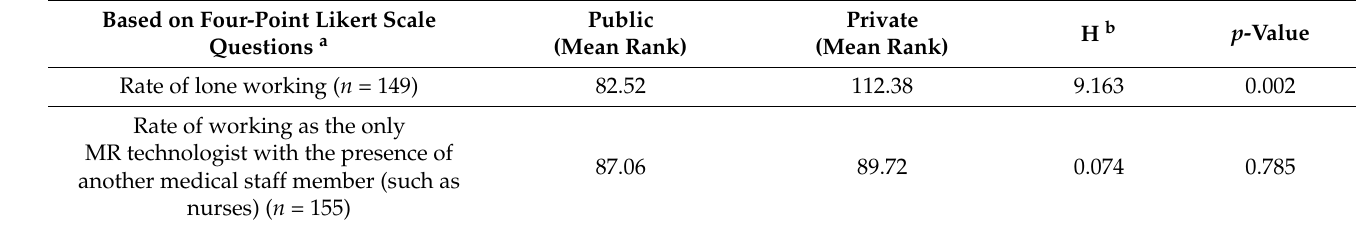
Table 4. Comparison between the workplaces and the rates at which MRI technologists work alone or in the presence of other staff members.